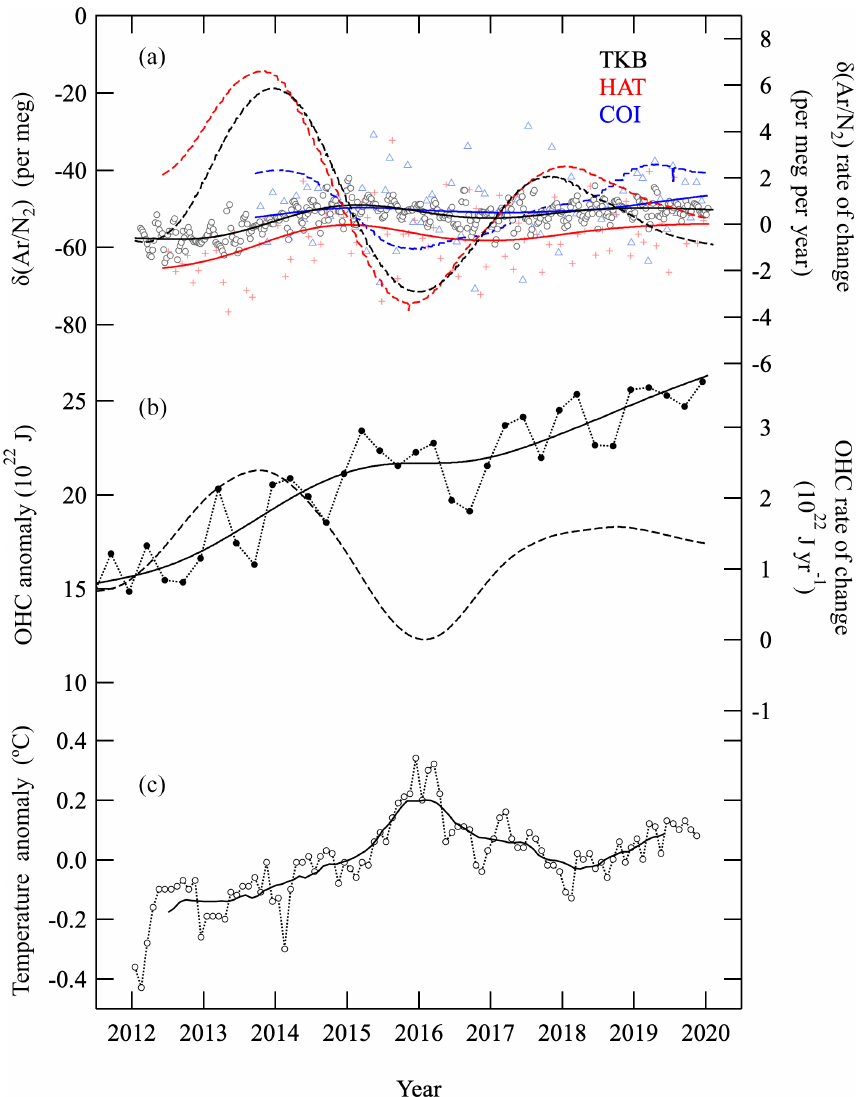
Figure 4. (a) δ (Ar / N 2 ) values at TKB (black open circles), HAT (red crosses) and COI (blue triangles), after subtracting seasonal cycles and shorter-term variations less than 36 months. Interannual variations of δ (Ar / N 2 ) at TKB, HAT and COI are shown by black, red and blues solid lines, respectively. Rates of change of δ (Ar / N 2 ) at TKB, HAT and COI are also shown by black, red and blue dashed lines, respectively. (b) 0–2000m global ocean heat content (OHC) from NOAA/NCEI (filled circles), its long-term trend (solid line) and increase rate (dashed line). The baseline period for OHC is the mid-1980s. (c) Global average surface temperature anomalies. Monthly and their 12-month running mean values are shown by open circles and the solid line,